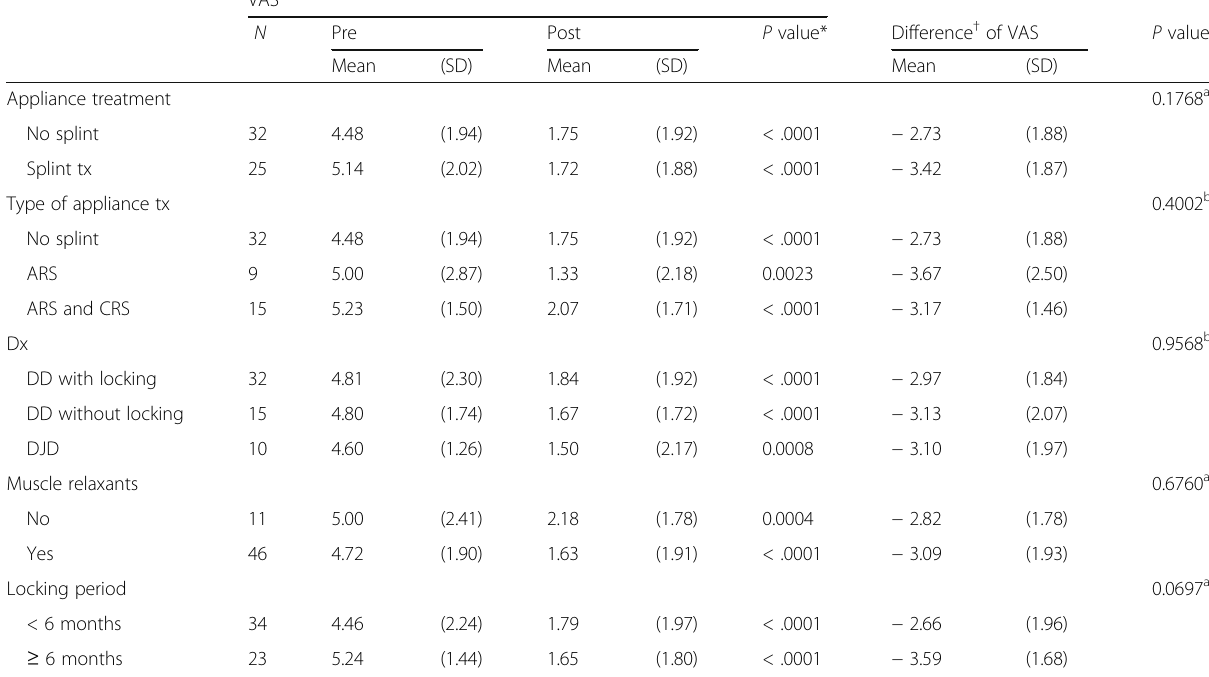
Table 3 Improvement of VAS score due to various